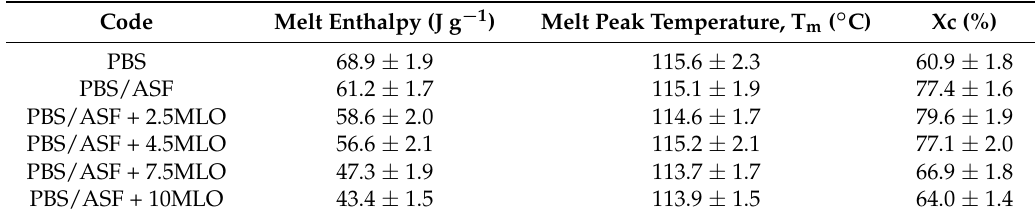
Table 3. Main thermal parameters of neat PBS and PBS/AHF composites with different percentage of MLO obtained by differential canning calorimetry